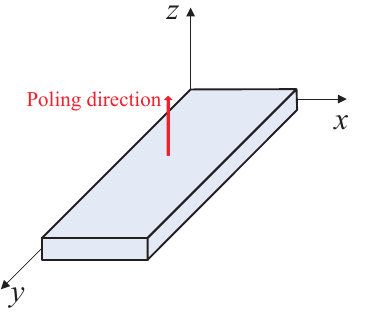
Figure 7. Schematic of a piezoelectric element.